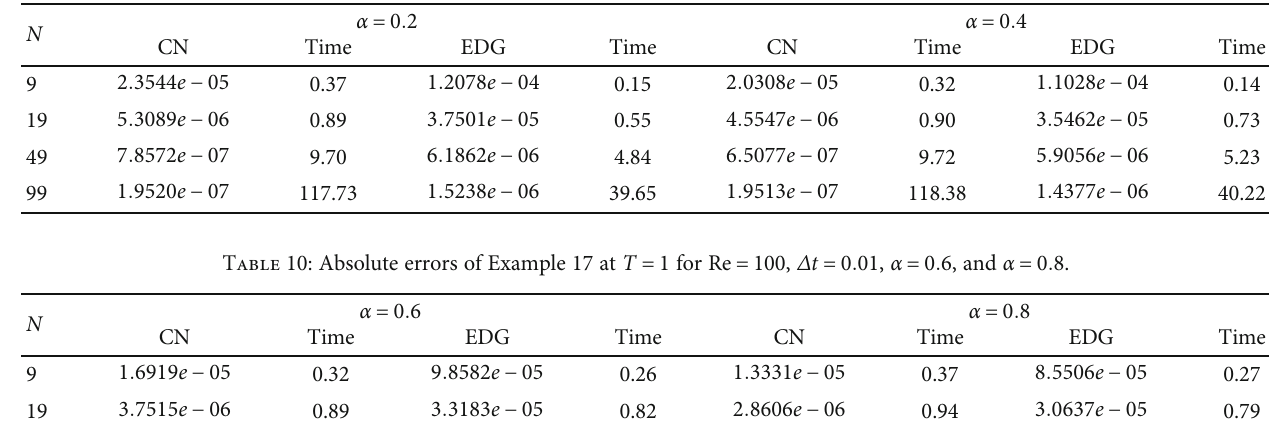
Table 9: Absolute errors of Example 17 at T = 1 for Re = 100 , Δ t = 0 : 01 , α = 0 : 2 , and α = 0 : 4 .